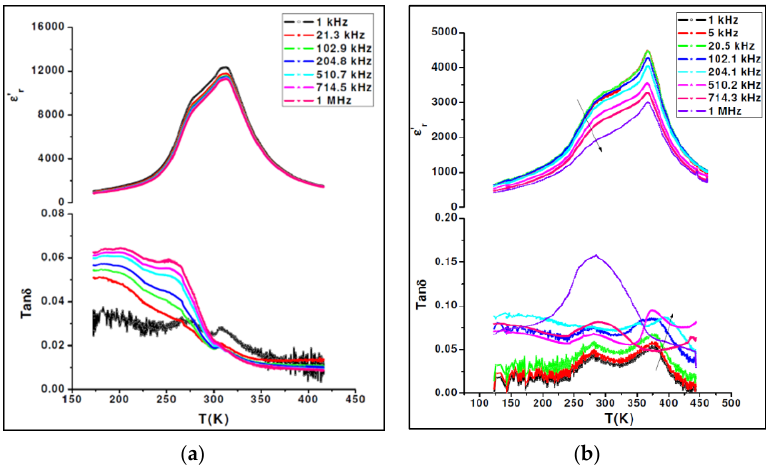
Figure 9. ( a ) Dielectric constant and loss tangent as a function of temperature and frequency of a randomly oriented BCTZ2 sample; and ( b ) temperature dependence of dielectric constant and loss tangent at various frequencies of [001] pc oriented BCTZ3 single crystal (arrows indicate the direction of increasing frequency).